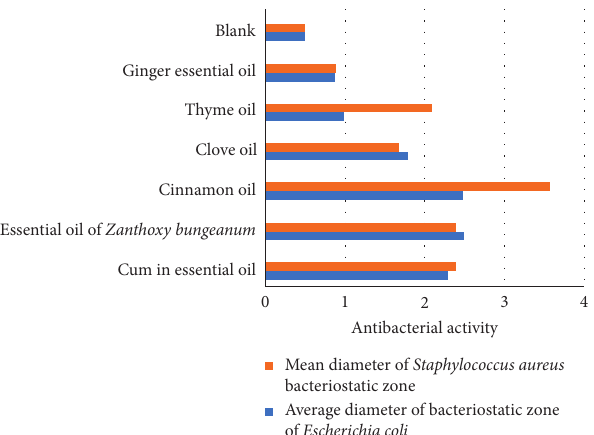
Figure 1: Determination of bacteriostatic zone of six essential oils against two kinds of